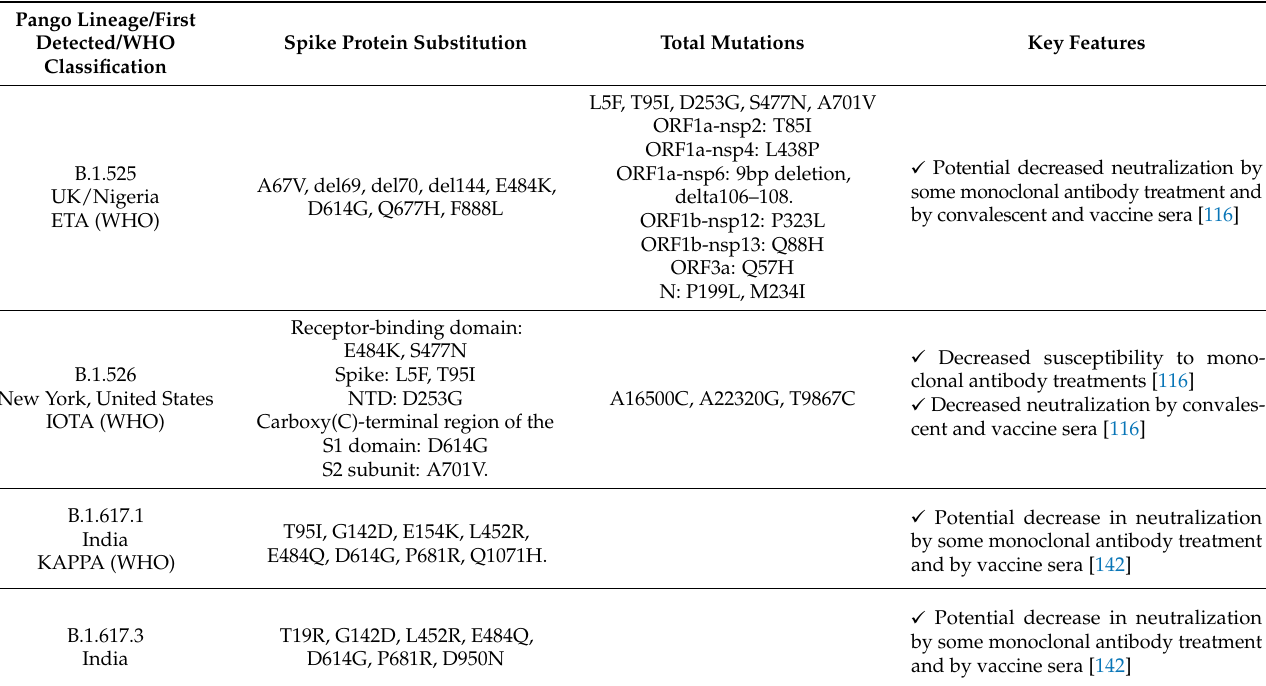
Table 4. Variants of Interest: Mutations and key features.